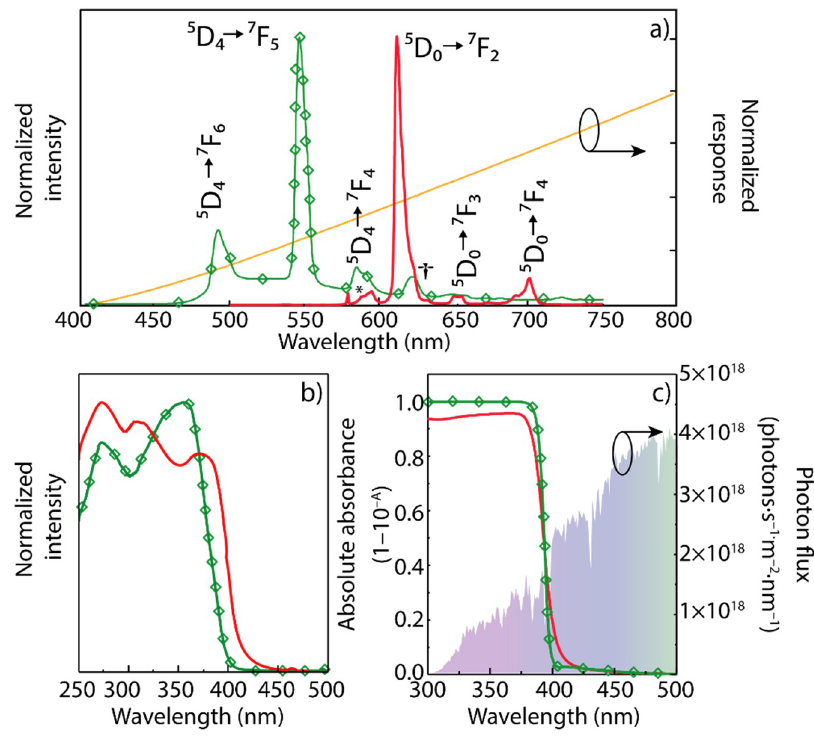
Figure 2. ( a ) Emission spectra excited at 360 nm for PMMA-Tb (green line with diamonds) and 380 nm for PMMA-Eu (red solid line). The asterisk marks the region of the superposition between the Eu 3+ 5 D 0 → 7 F 0-1 and the Tb 3+ 5 D 4 → 7 F 4 transitions. The cross marks the region of the superposition between the Eu 3+ 5 D 0 → 7 F 2 and the Tb 3+ 5 D 4 → 7 F 3 transitions. The orange line is the normalized c-Si PV devices absorption curve; ( b ) Excitation spectra for PMMA-Tb monitored at 545 nm and PMMA-Eu monitored at 612 nm. ( c ) Absorption spectra for PMMA-Tb, PMMA-Eu, and AM1.5G photon flux (the color code for ( b ) and ( c ) is the same as in ( a )).